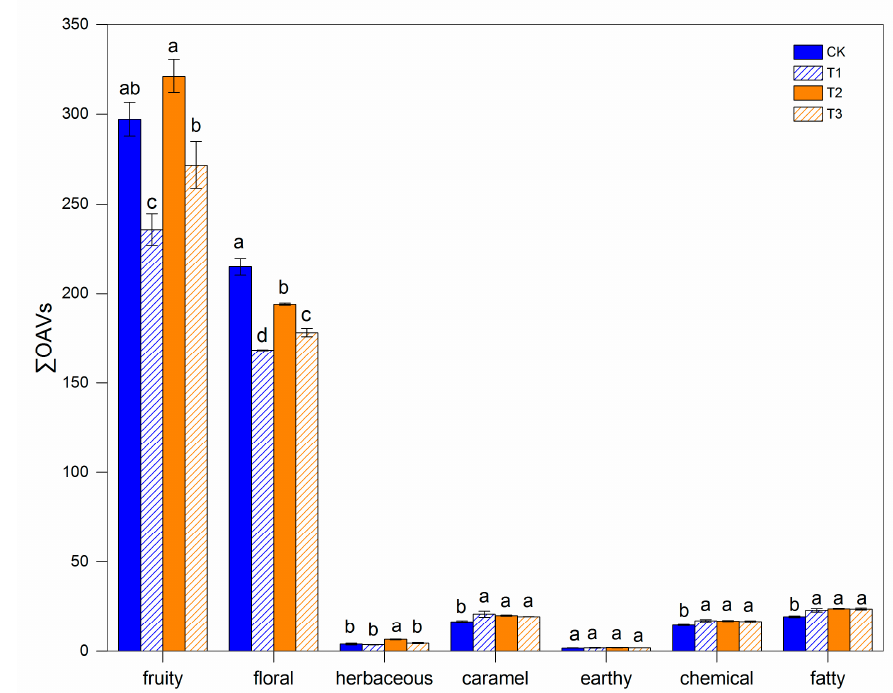
(cid:80) Figure 1. Total OAVs ( OAV) of aroma series in wines produced from control berries (CK) and Figure 1. Total OAVs ( ∑ OAV) of aroma series in wines produced from control berries (CK) and sequential harvest berries (T2, T3, and sequential harvest berries (T2, T3, and T4).